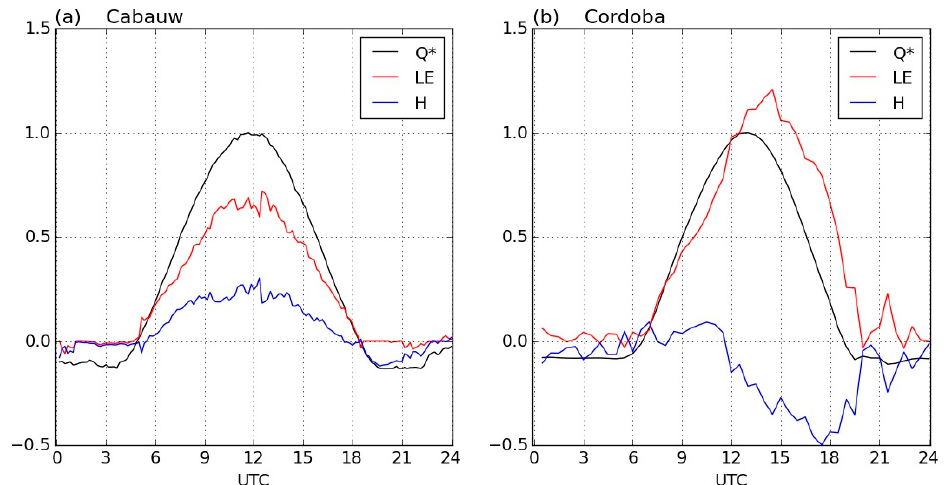
Figure 3. Diurnal variation of the terms of the energy budget equation—latent (red line) and sensible (blue line) heat fluxes and net radiation (black line)—on a sunny day for ( a ) Cabauw (28 May 2012, no local advection) and ( b ) the lysimeter Cordoba site (29 July 2009, with local advection). All values are based on observations gathered at both sites and are normalized by the local net radiation maximum.